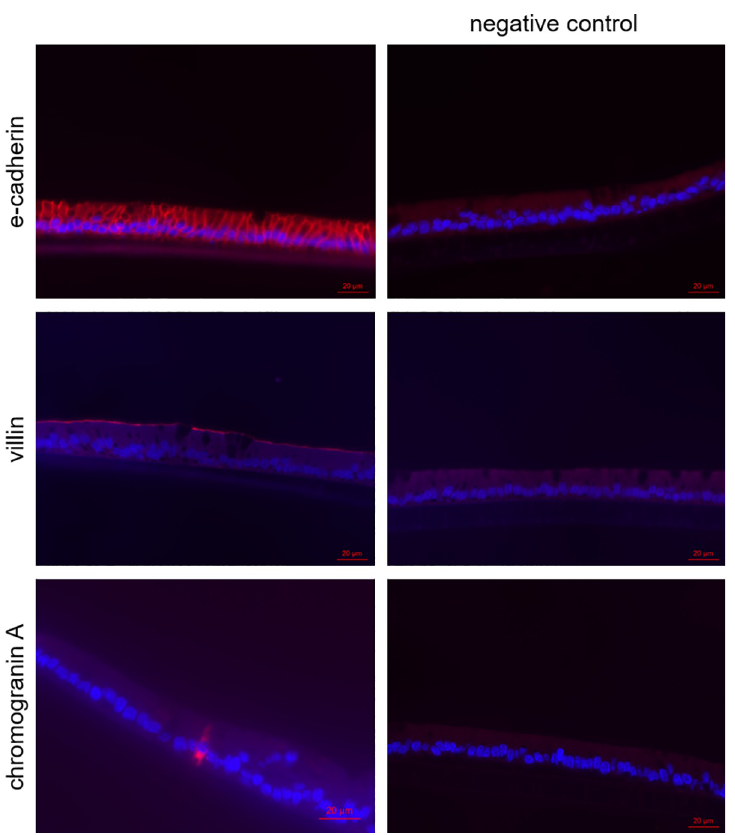
Fig 7. Immunofluorescence staining (cross sections) of jejunum organoids grown in 2D on Snapwells 1 for 18 days. E-cadherin, villin and chromogranin A are displayed in red, nuclei are counterstained in blue. Representative figures are shown, chosen from three independent experiments with three technical replicates per cellular approach.